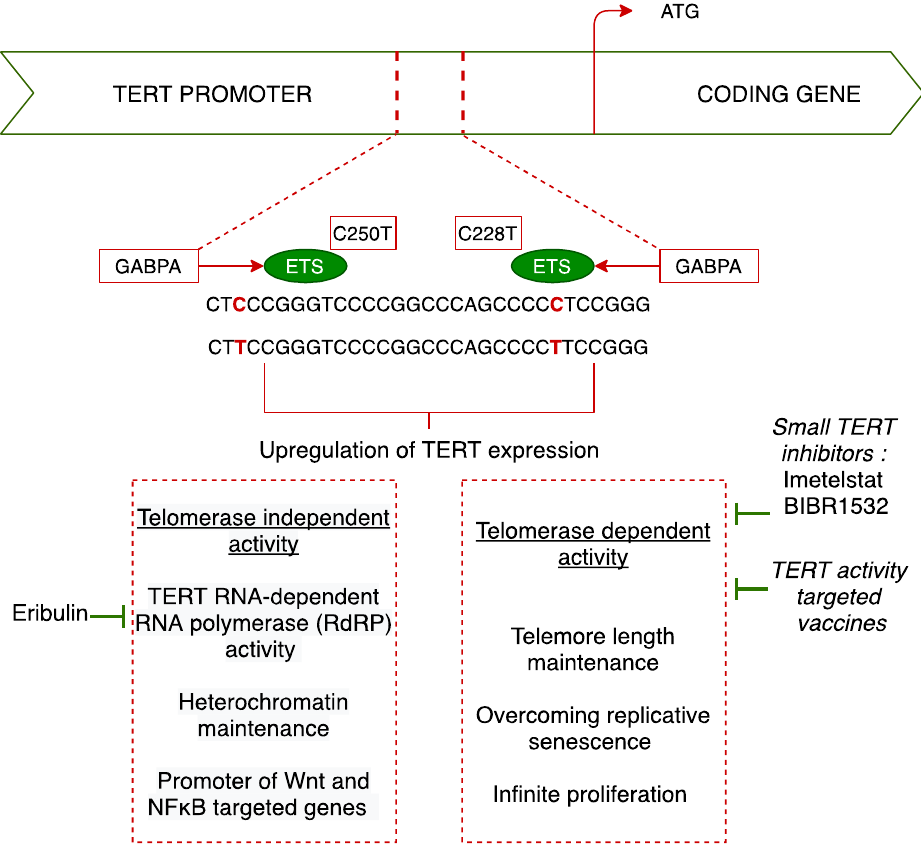
Figure 3. Physiopathological consequences of TERTp alterations in glioblastoma and therapeutic perspectives.